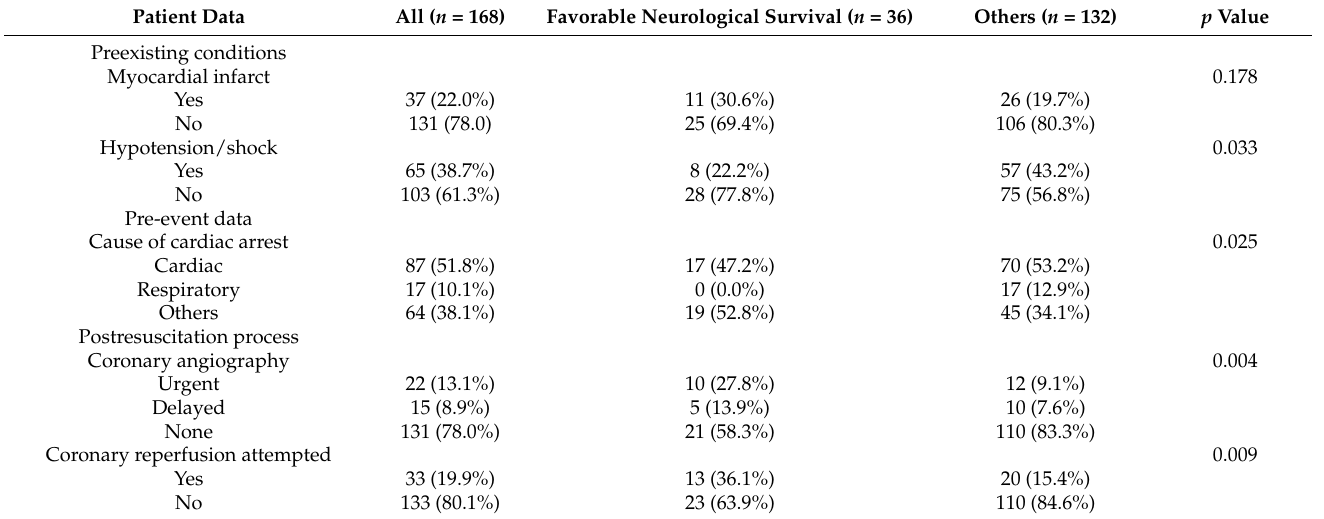
Table 2. Utstein style elements and favorable neurological survival in resuscitated